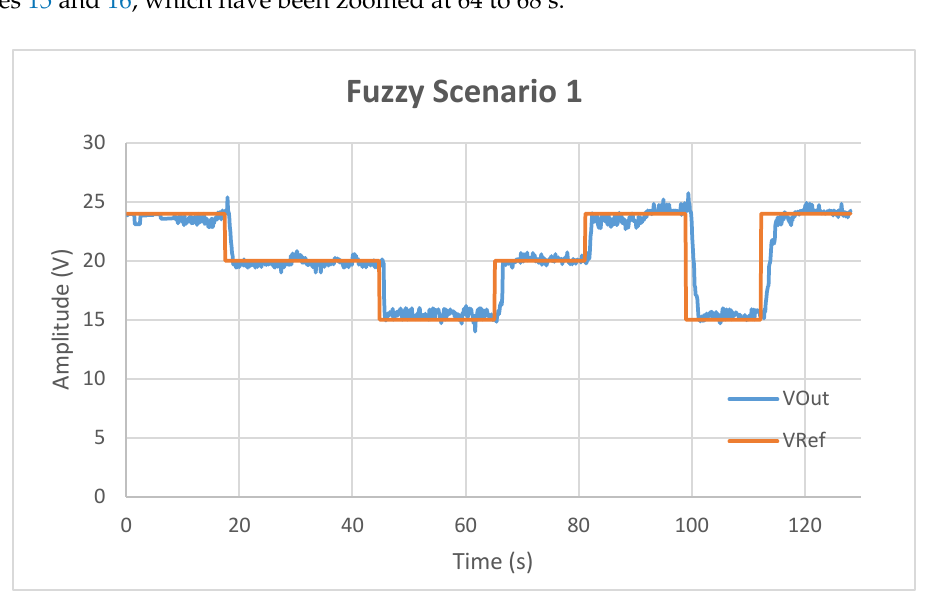
Figure 15. The results of set point changes with fuzzy logic controller.